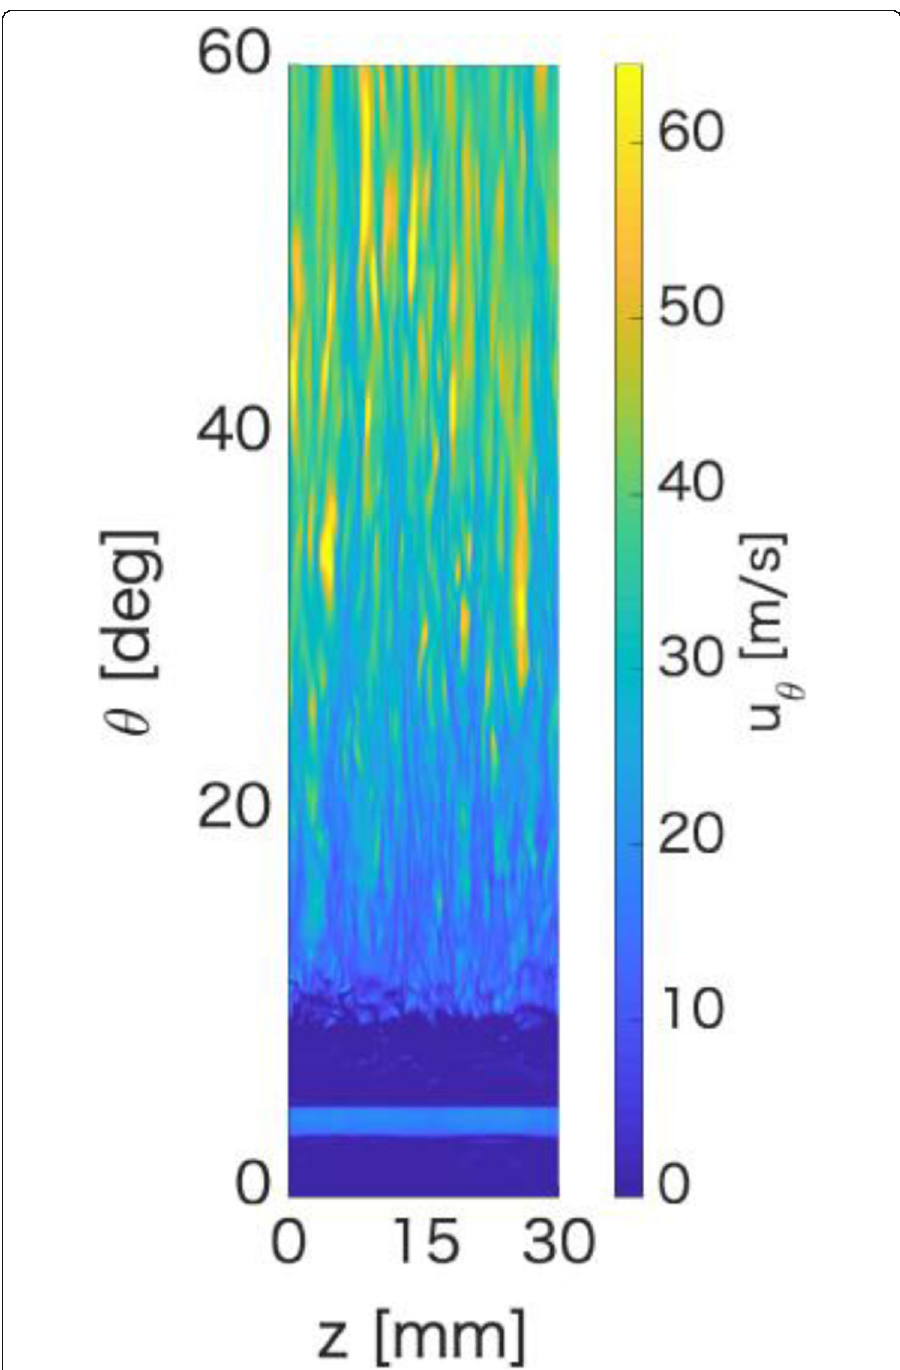
Fig. 9 The distribution of near-wall circumferential velocity (Point